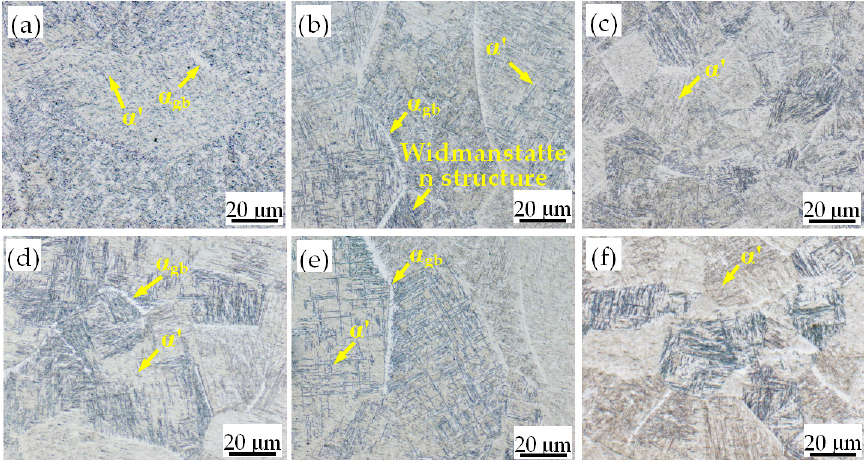
Figure 10. Microstructure of laser–TIG hybrid welded joints with different currents: ( a ) I = 30 A, arc zone; ( b ) I = 30 A, laser zone; ( c ) I = 30 A, HAZ; ( d ) I = 50 A, arc zone; ( e ) I = 50 A, laser zone; ( f ) I = 50 A, HAZ.